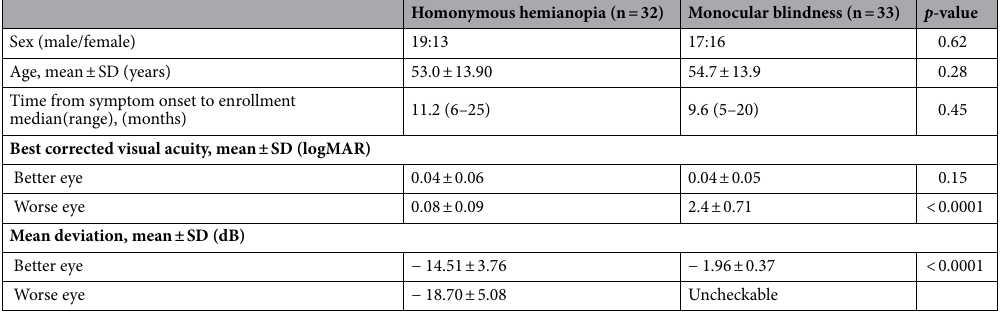
Table 1. Patient demographics in two groups.